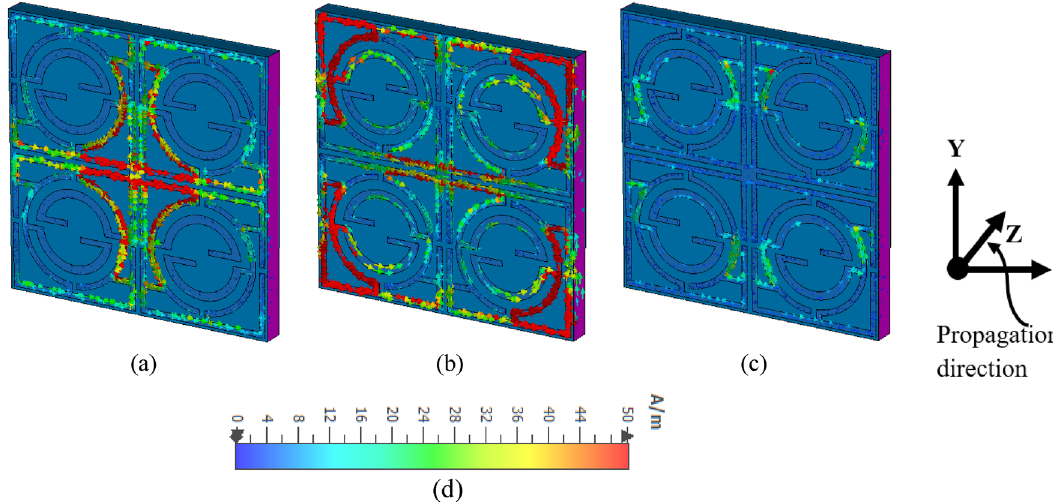
Figure 10. Surface current distribution on MTM: ( a ) 1.98 GHz, ( b ) 4.74 GHz, ( c ) 8.34 GHz, ( d ) scale with color coded bar for the magnitude of the current ( CST microwave studio suite